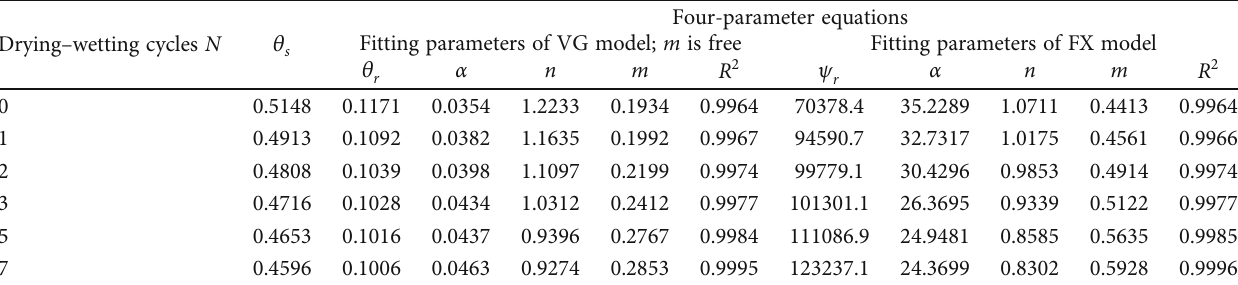
Table 4: Best- fi t parameters and R 2 values for the VG and FX model (four-parameter). Drying – wetting cycles